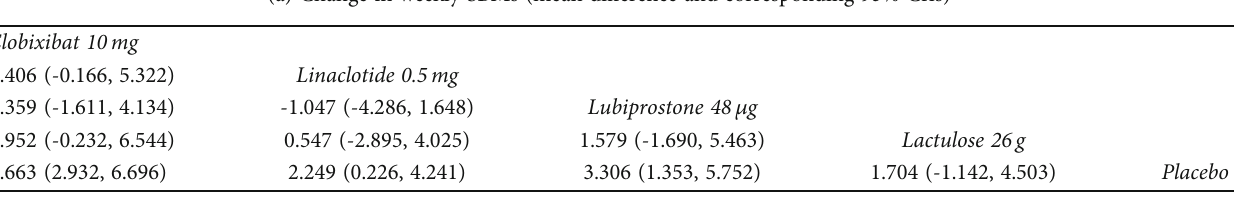
Figure 5: Forrest plot of Bayesian network meta-analysis results of the change in weekly SBMs compared between all doses. Table 3: The relative e ffi cacy of typical doses of subject mediations compared with placebo. (a) Change in weekly SBMs (mean di ff erence and corresponding 95%